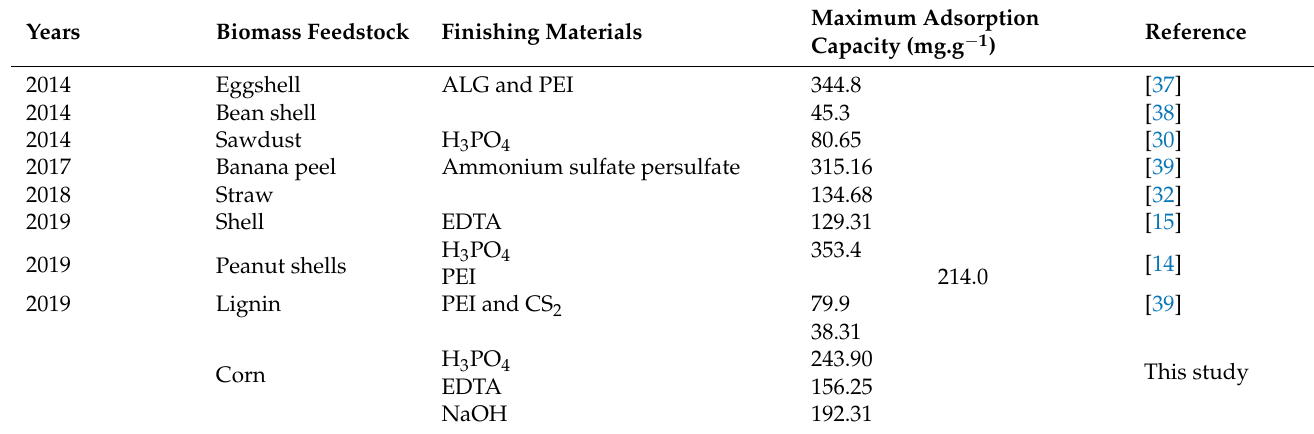
Table 9. Comparison of various representative Pb(II)